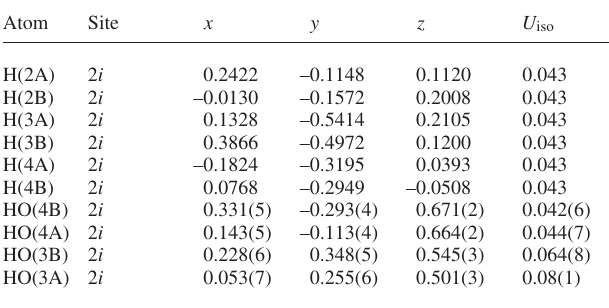
Table 2. Atomic coordinates and displacement parameters (in Å 2 )